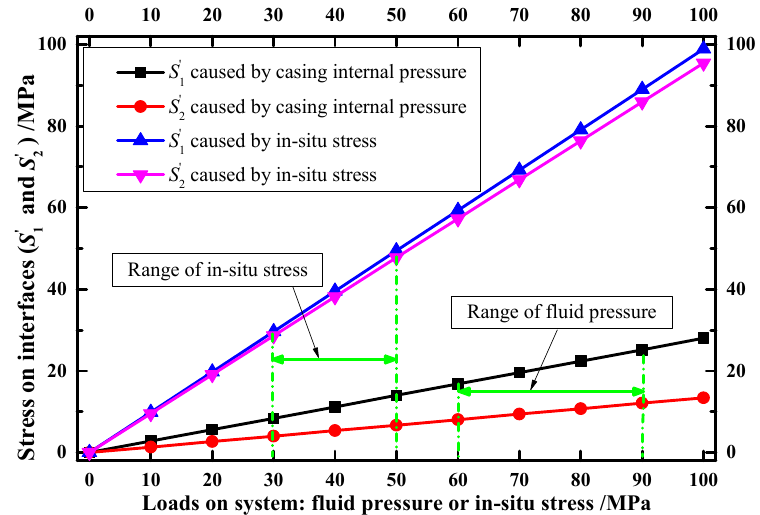
Table 1 . Model parameters for casing, cement sheath and formation.